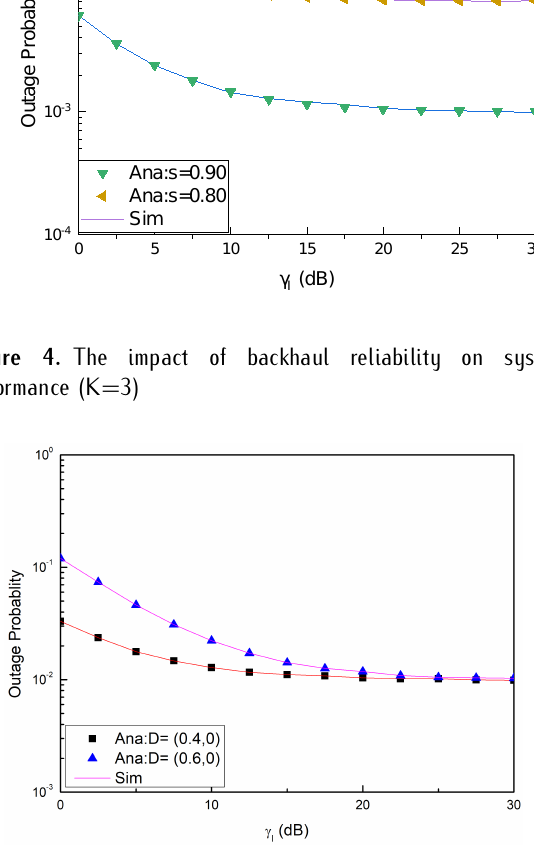
Figure 5. The impact of receiver’s possition on system performance (s=0.9,